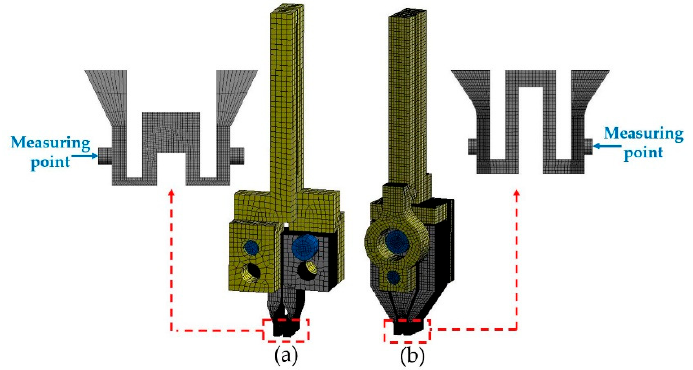
Figure 9. The optimum mesh model of ( a ) series and ( b ) parallel WTs for